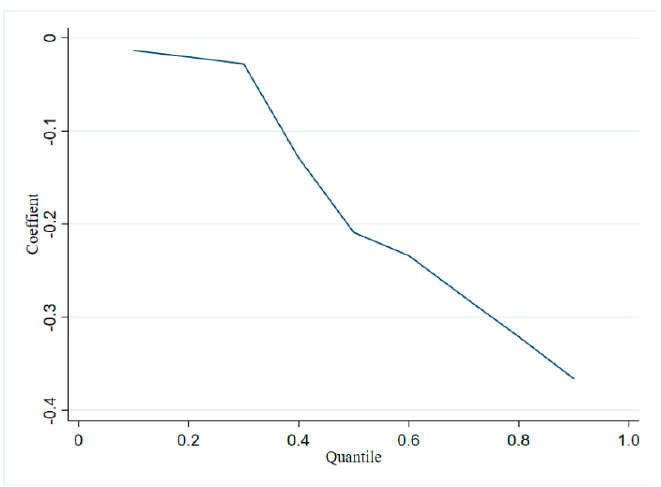
Figure 2. Quantile regression results.